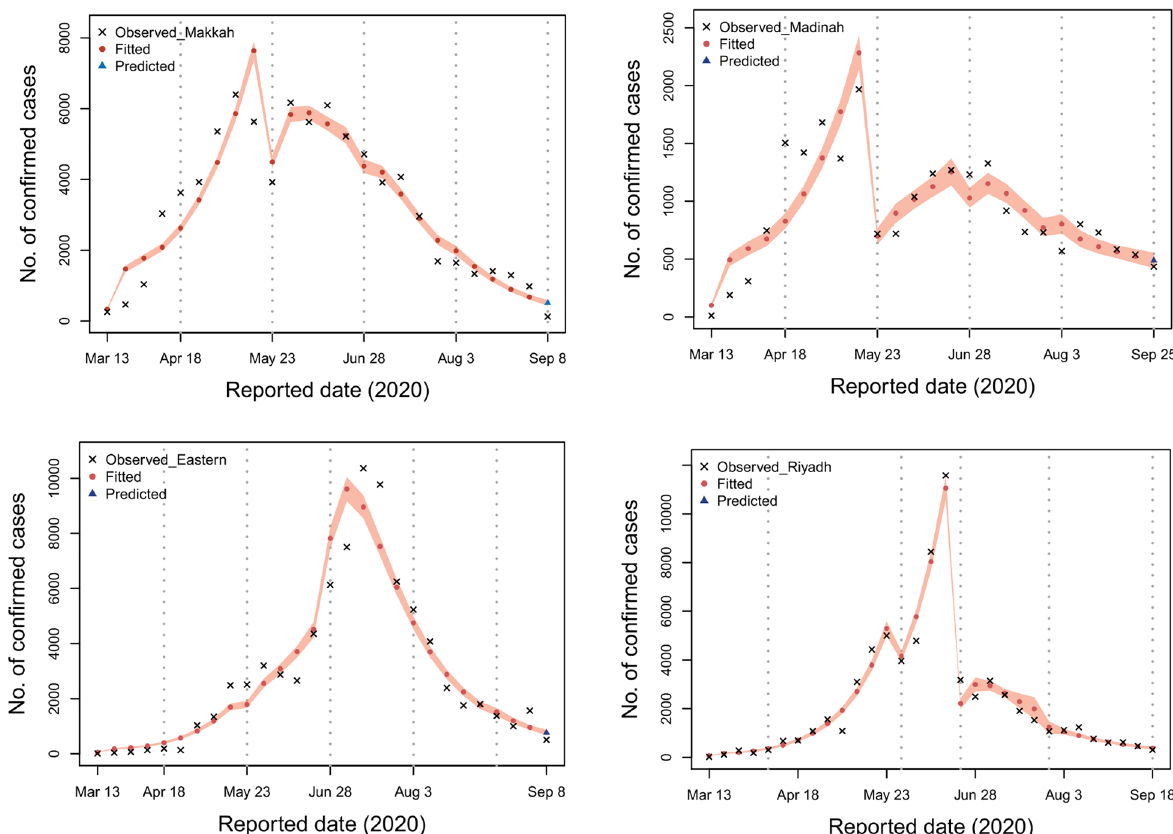
Figure 2. With the use of the Delay Rejection Adaptive Metropolis method, the relevant parameters were estimated for each of the four areas of interest by fitting the data from 13th March until 25th